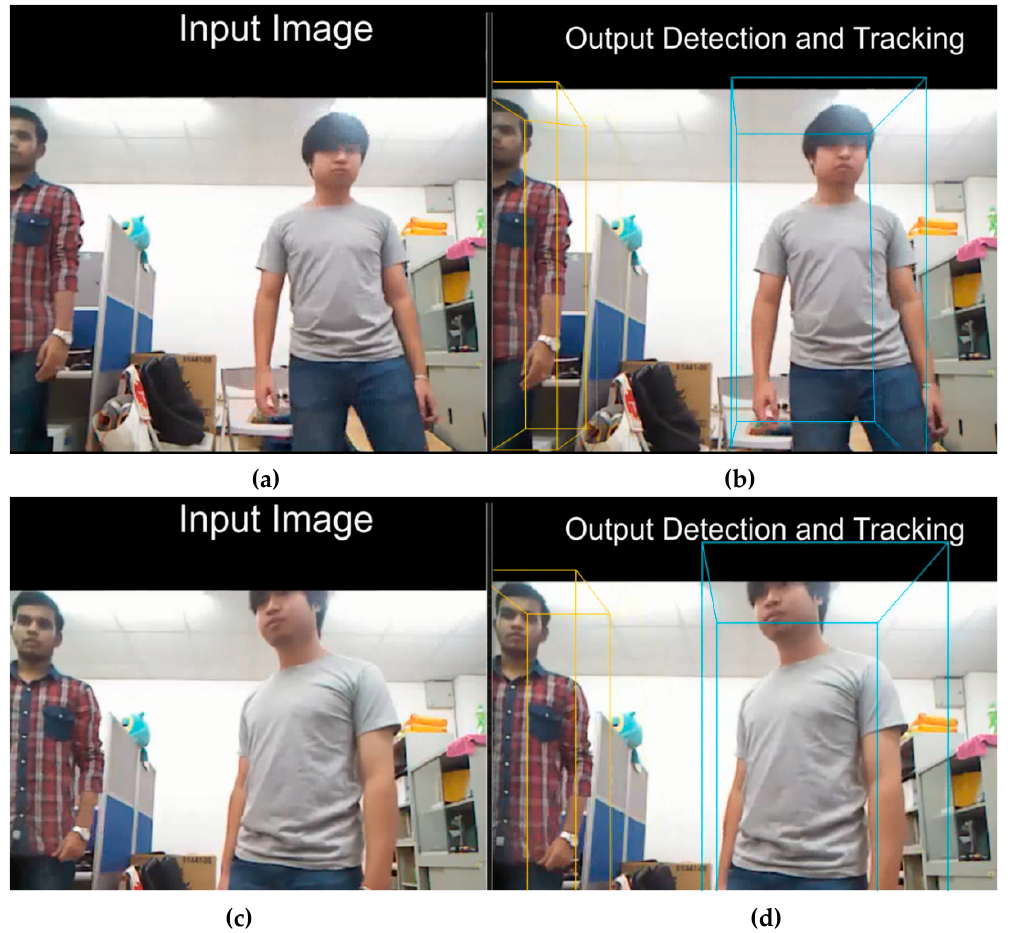
Figure 9. Recorded image sequence of detecting and tracking two humans in the room.